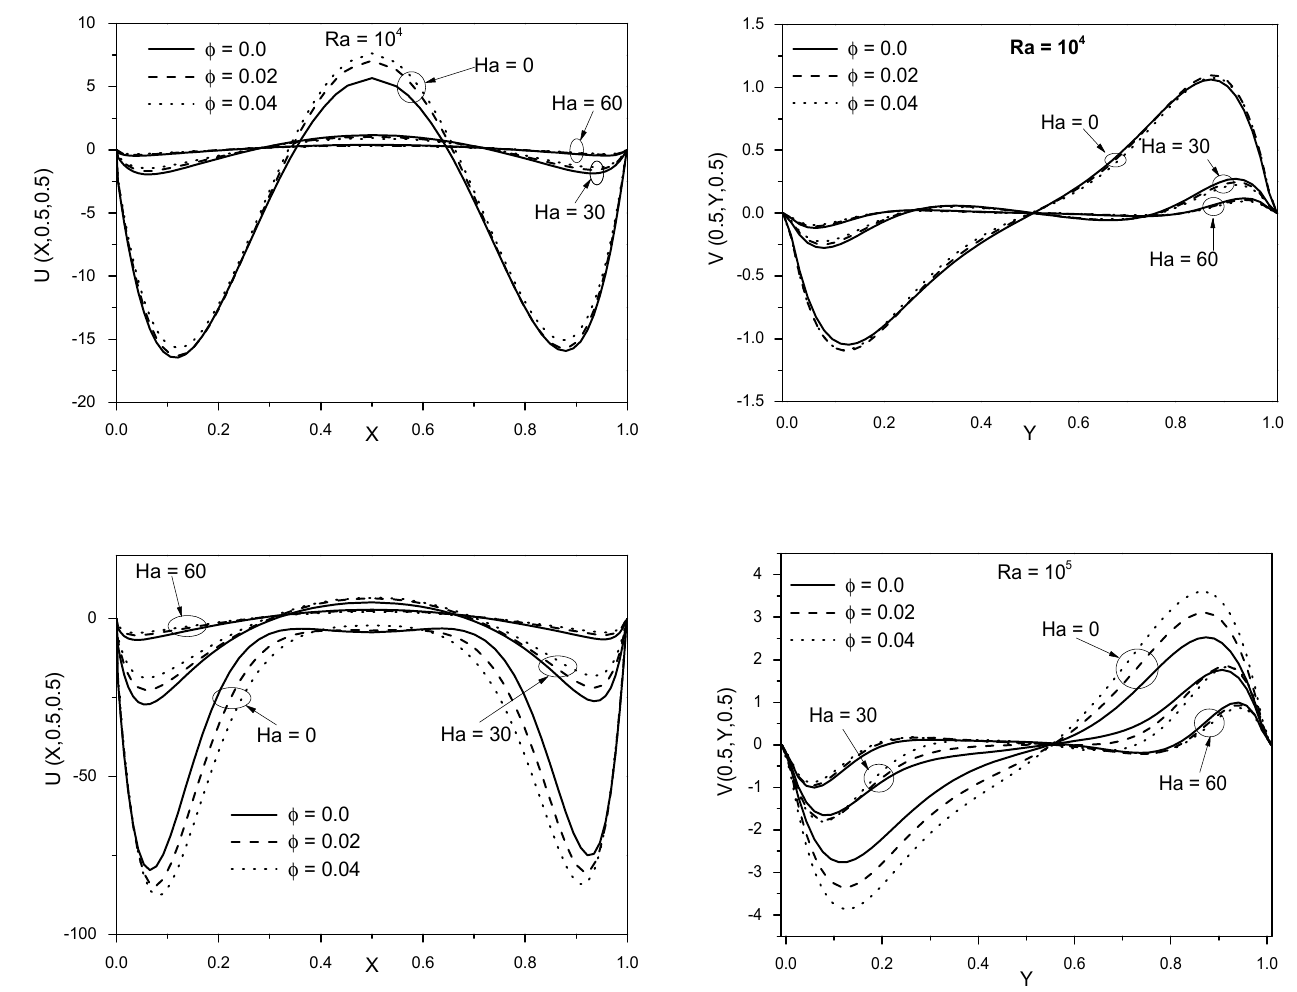
Figure 6. The variation of the velocity profiles along the X -axis ( left ) and Y -axis ( right ) for different Rayleigh numbers, Hartmann numbers, and the solid volume fractions at (d p = 10 nm). The influence of the Rayleigh and Hartmann numbers on the local Nusselt number at the cavity’s left cold sidewalls (Nu L ) is seen in Figure 7 for (d p = 10 nm and φ = 0.02). The link between the average Nusselt number and the solid volumetric fraction was depicted in Figure 8 for various Ra and Ha numbers and for (d p = 10 nm). The flow structure at (Y-Z) plane and (X = 0.5) inside the cavity filled with pure water [ φ = 0 (solid line)] and Cu-water nanofluid [ φ = 0.04 (dash line)] for various values of (Ra) and (d p ) was presented graphically at Figure 9. In this case, the Hartmann number is considered constant at (Ha =